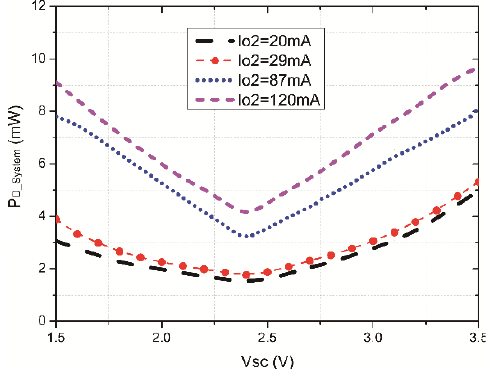
Figure 7. P D_system with V SC and I O 2